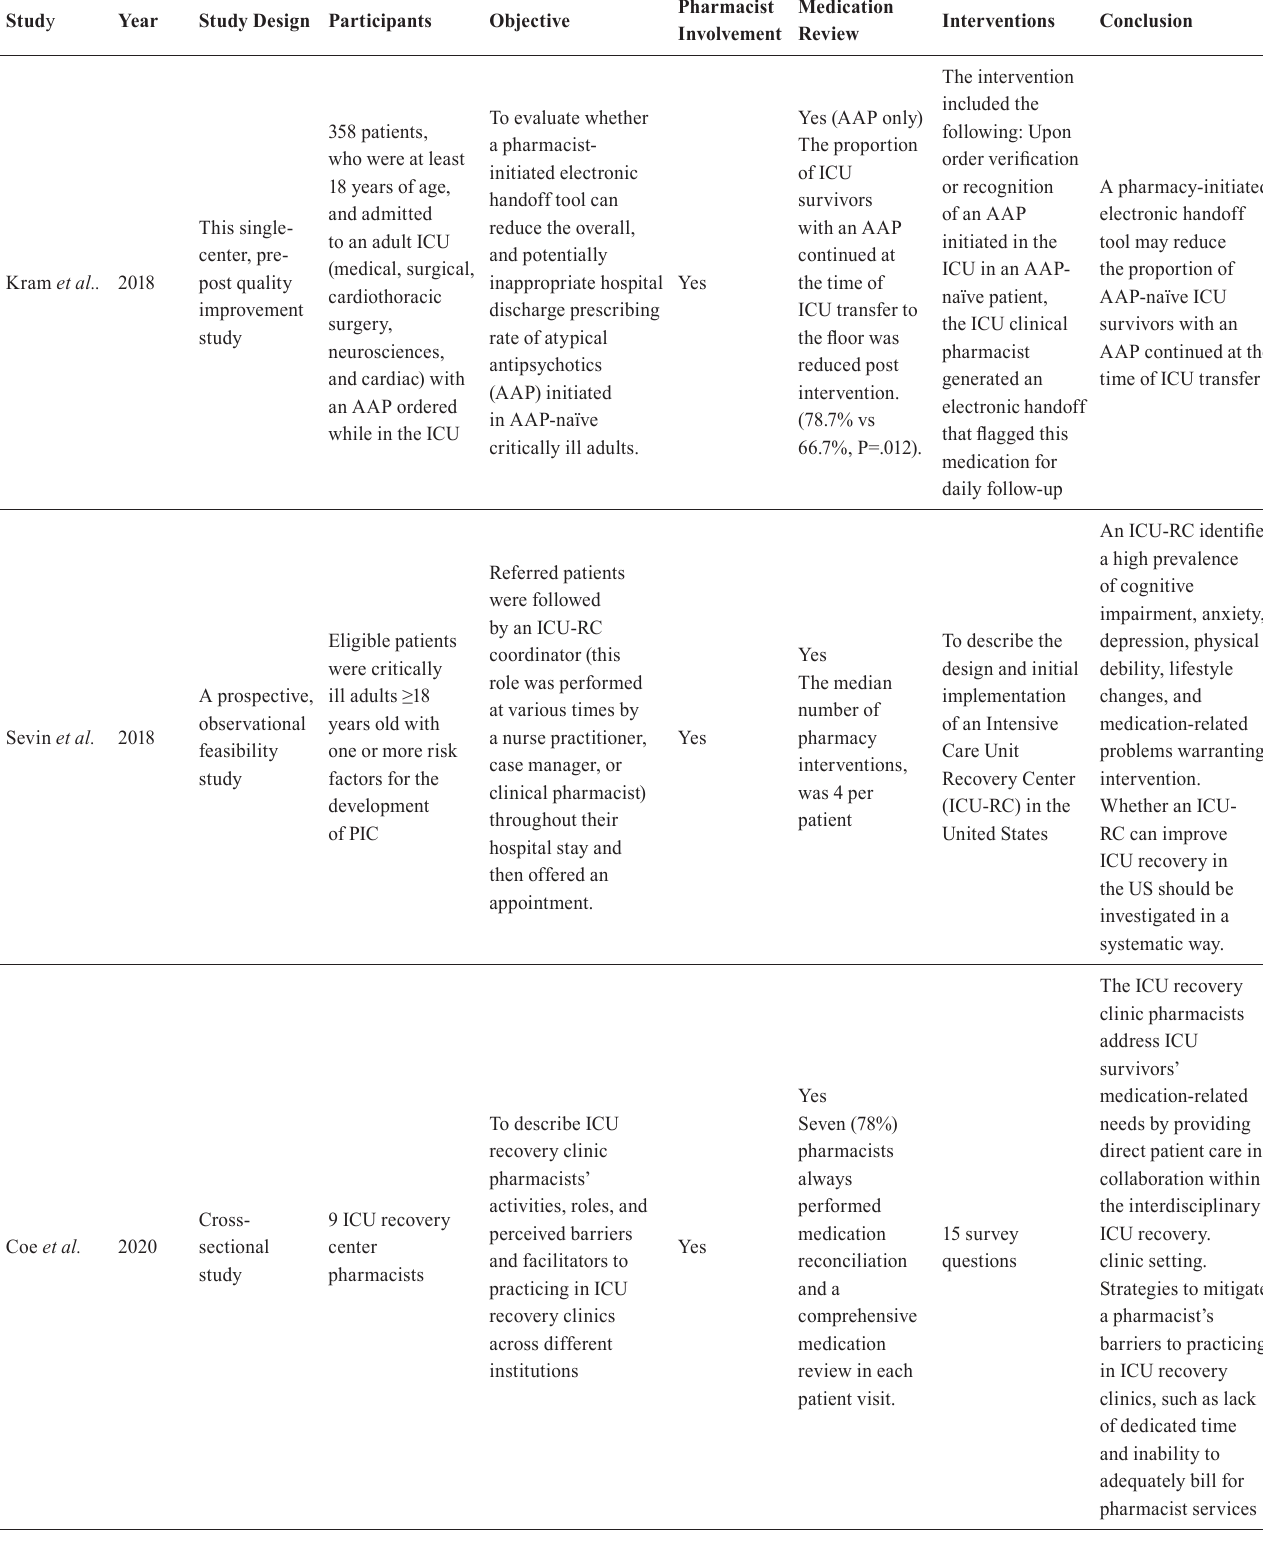
TABLE I - S ummary of the literature related to pharmacist contributions or medication review for post-ICU survivors